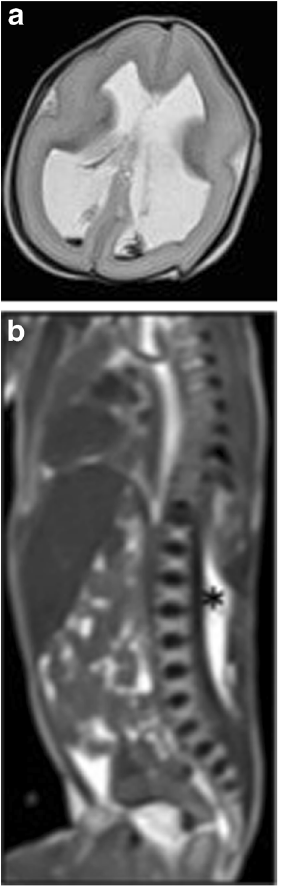
Fig. 7 PMFMRI of a 22 weeks gestation fetus, for which the pregnancy was interrupted for extensive spinal dysraphism. a Axial T2-W image shows bilateral ventriculomegaly. There is a small hemorrhage in the occipital horns that is considered as a postmortem change. b Sagittal T2-W image shows a close spinal dysraphism (asterisk)